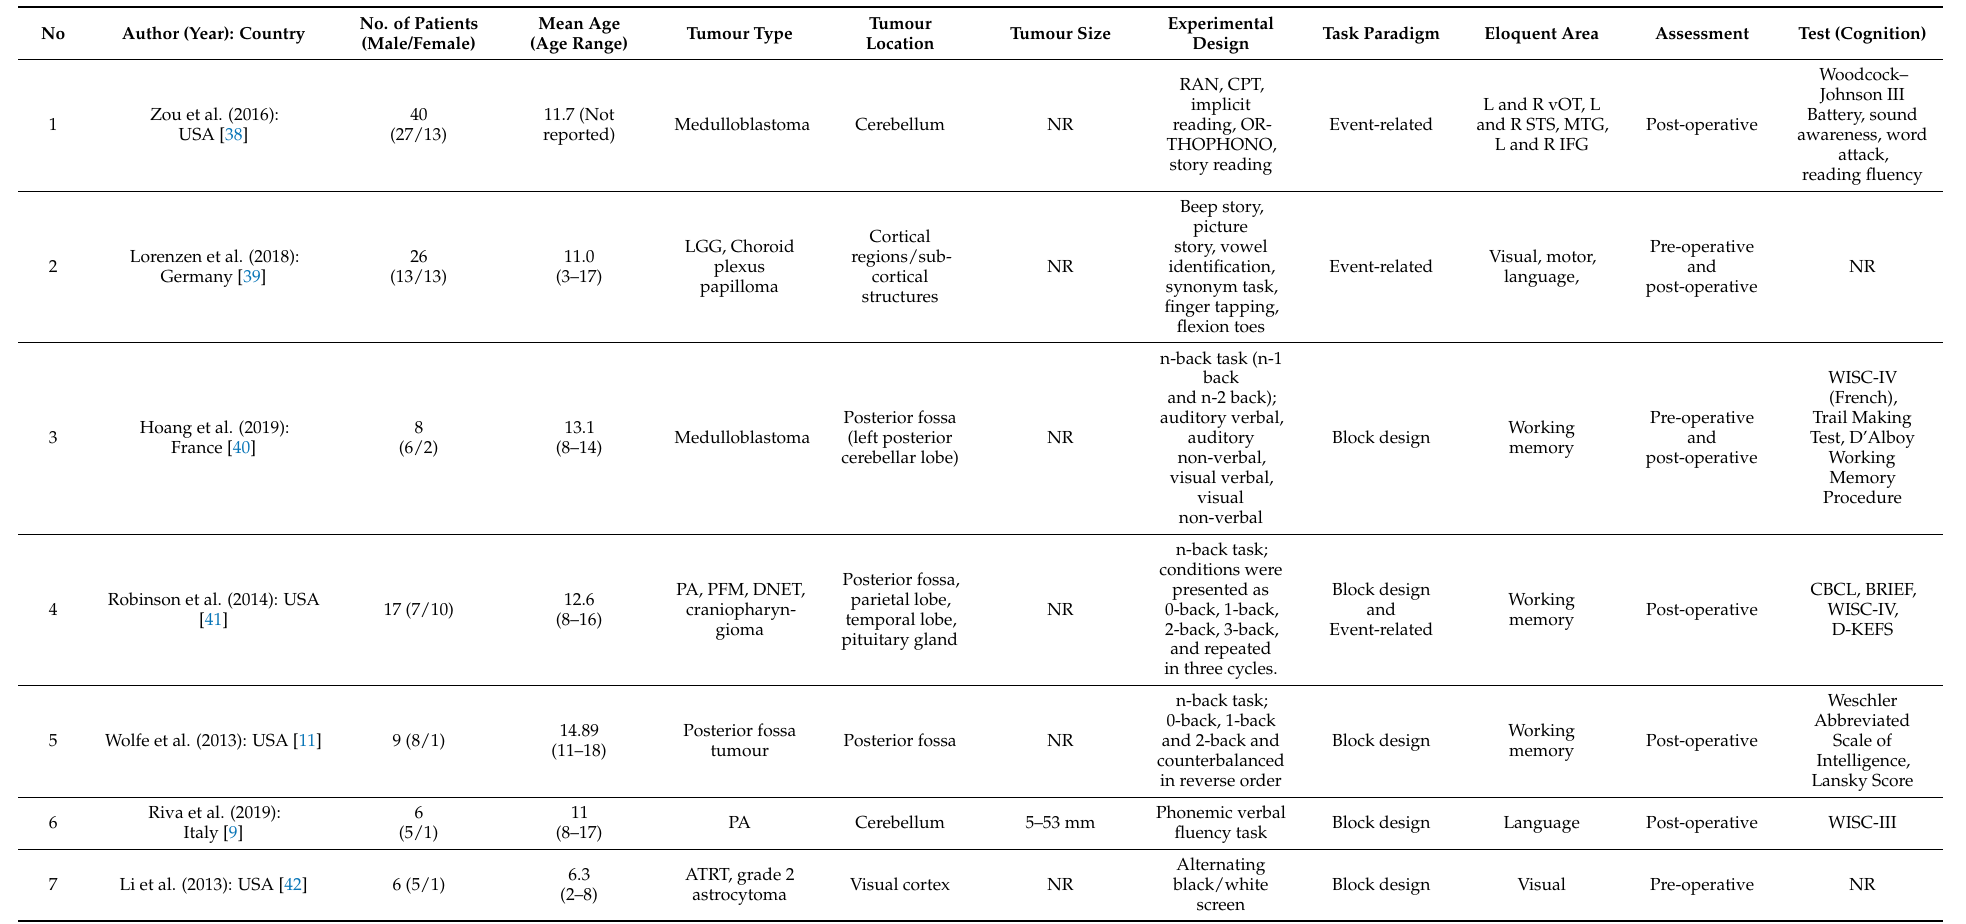
Table 3. Demographic data of patients, tumour characteristics and eloquent areas (task-based